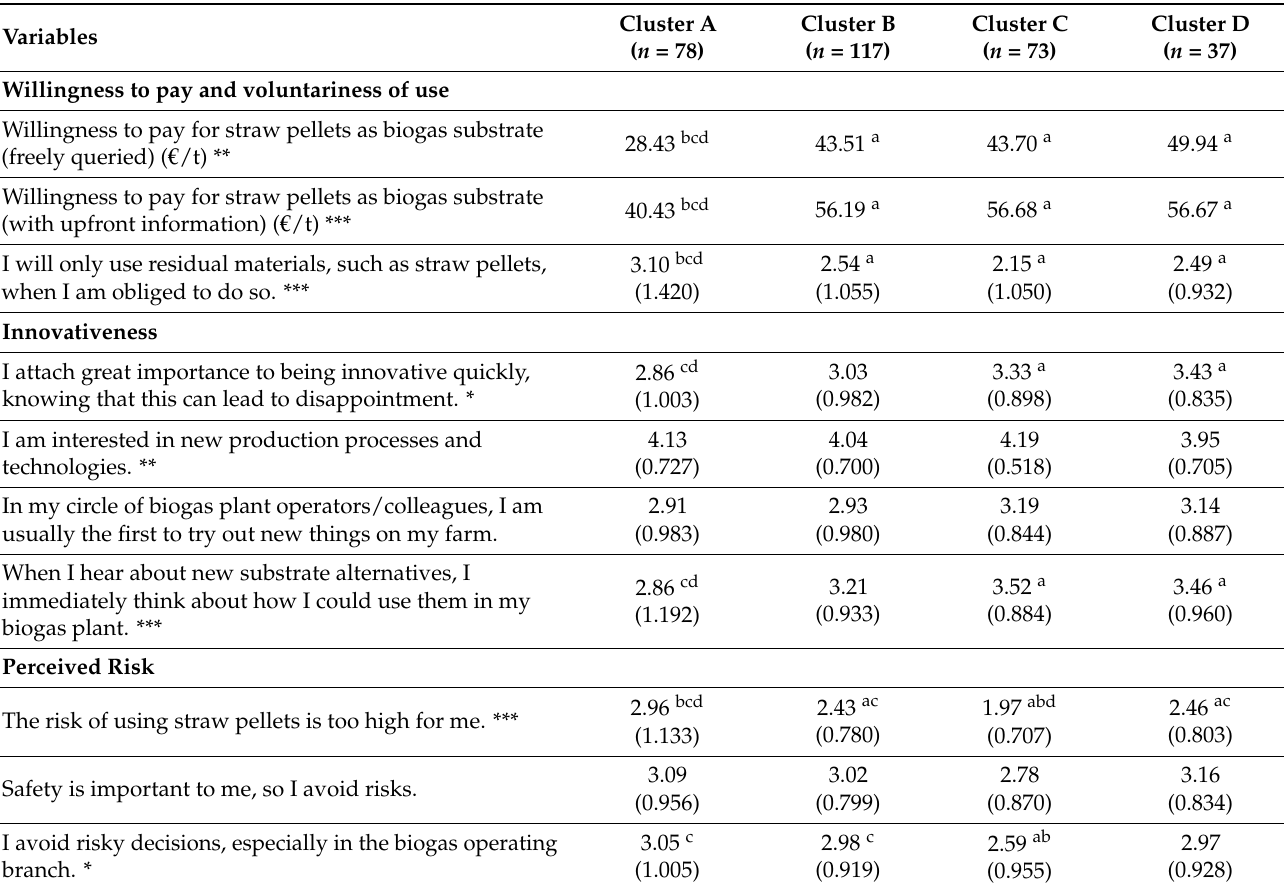
Table 3. Cluster description: Management behaviour and social